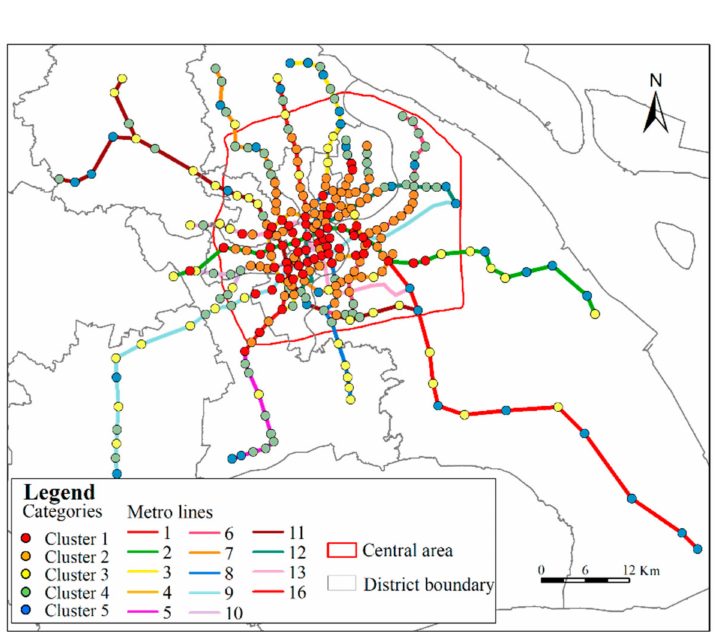
Figure 8. Results of the NPN